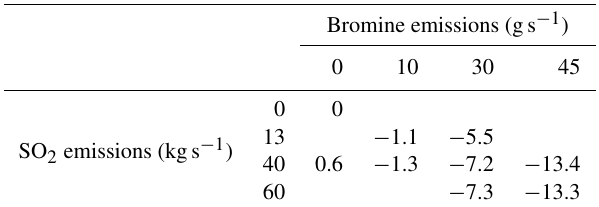
Table 6. (cid:49) O 3 values (compared to novolc run) in parts per bil- lion by volume for plumes aged 60 ± 5min on 1 August 2012 at 08:00UTC for various model runs with varying emissions. For all runs the Cl / Br, Br / HBr, OH / SO 2 , NO / SO 2 , H 2 O / SO 2 , Hg / SO 2 , and aerosol / SO 2 emission ratios remain the same as in main . The 40kgs − 1 row and 30gs − 1 column indicate the emission fluxes used in main